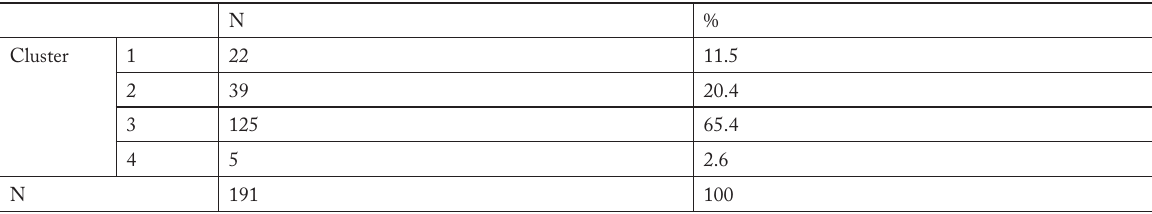
Figure 1. The optimal number of clusters according to the Elbow method. Table 1. Distribution of clusters according to the k-means clustering.